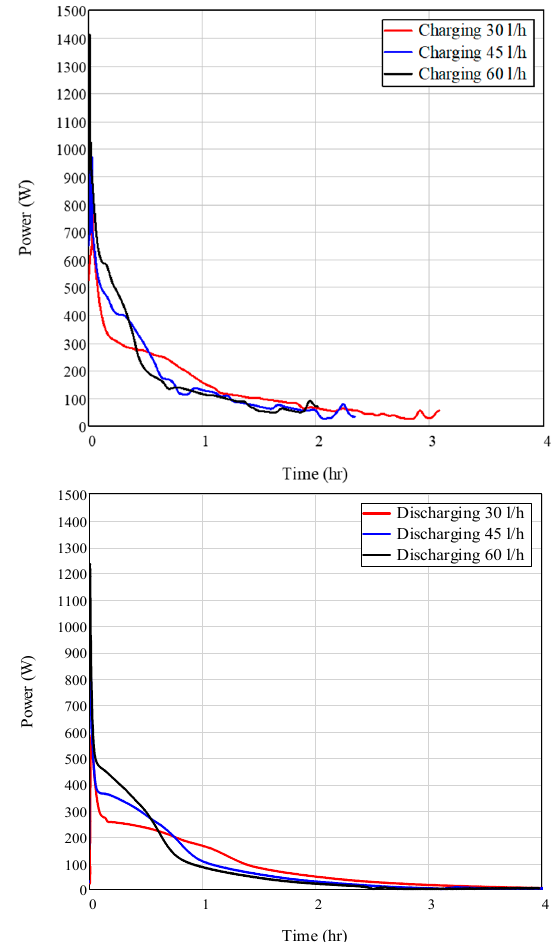
Figure 9. Heat power through HTF temporal evolution for A44 and different flow rates. Top : charging and bottom : discharging.